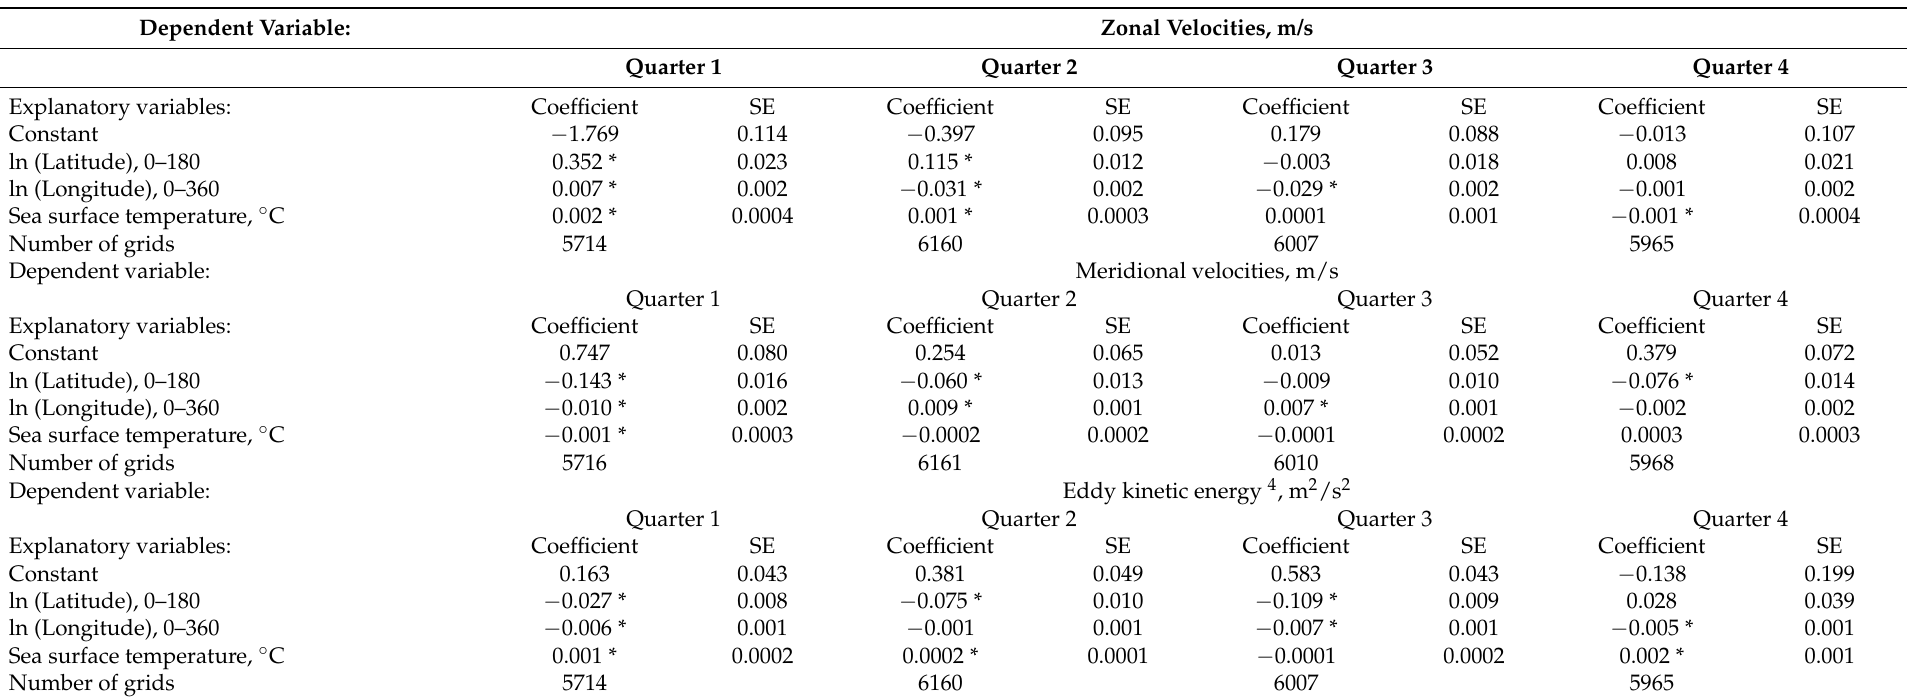
Table 7. Efficient estimates of static random effects models using quarterly data for 2000–2019 for 1 × 1 degree grids on zonal and meridional ocean surface current velocities and eddy kinetic energy in the Northern hemisphere explained by geodesic variables, time indicators for the years, and sea surface temperatures 1,2,3